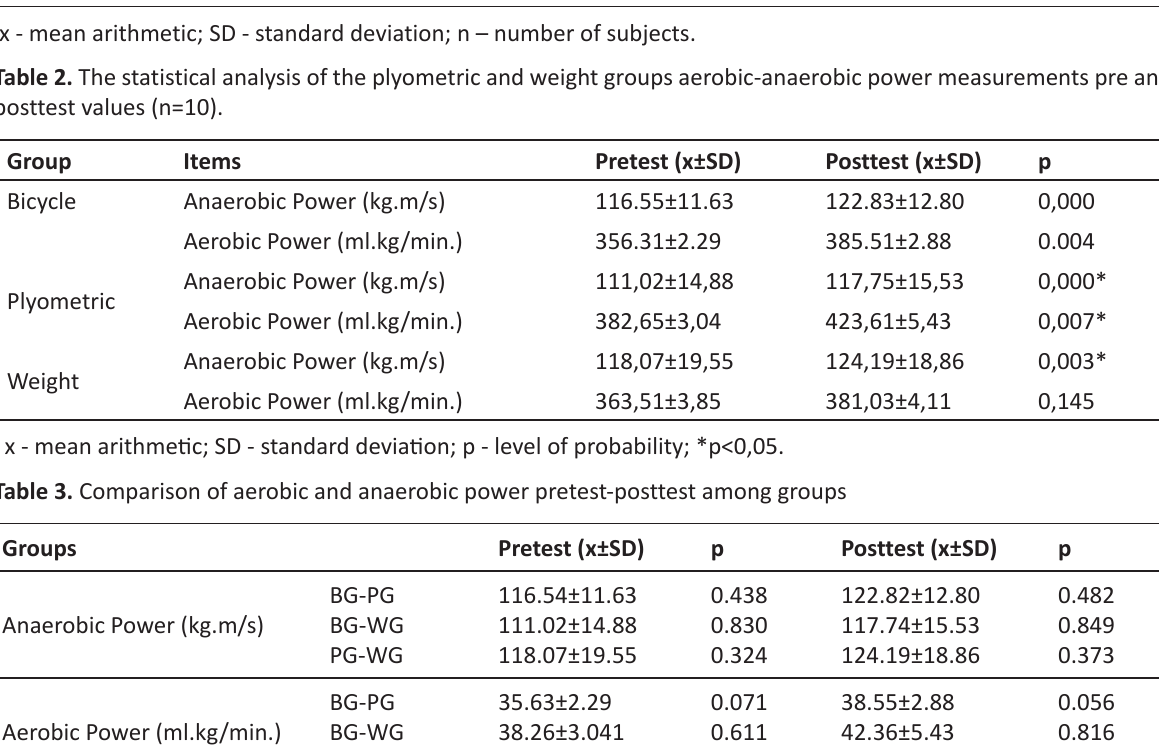
x - mean arithmetic; SD - standard deviation; p - level of probability; *p<0,05; BG - Bicycle Group; PG - Plyometric Group; WG - Weight